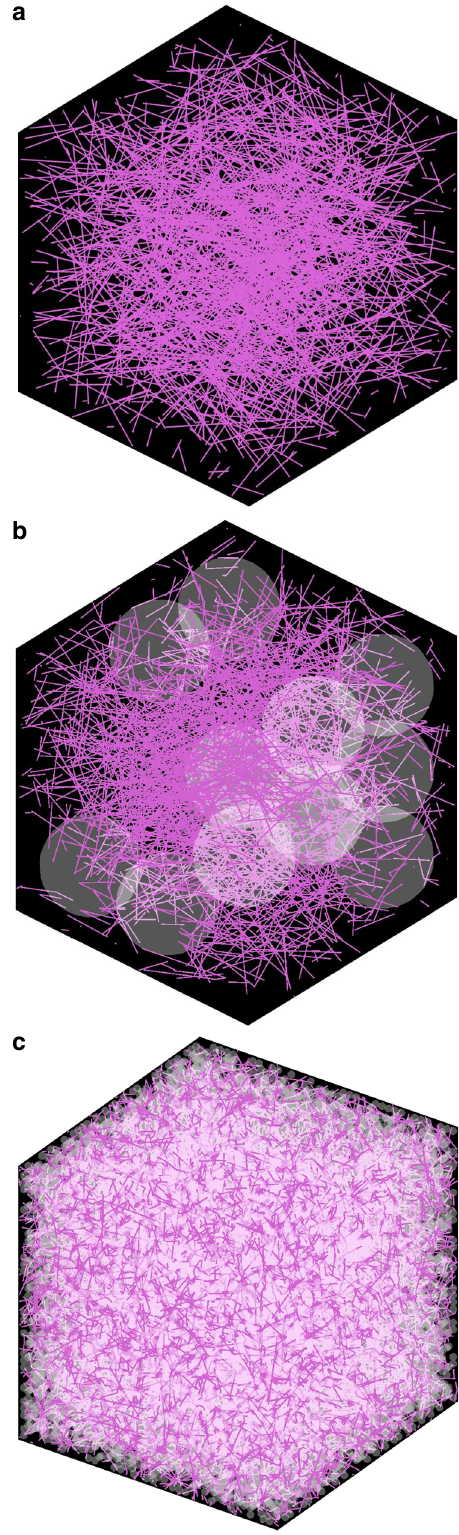
Fig. 5 Simulation images of CNT networks. a No silica particle is contained. b Micro-size sphere (diameter of 3 μ m). a and b are the same domain size